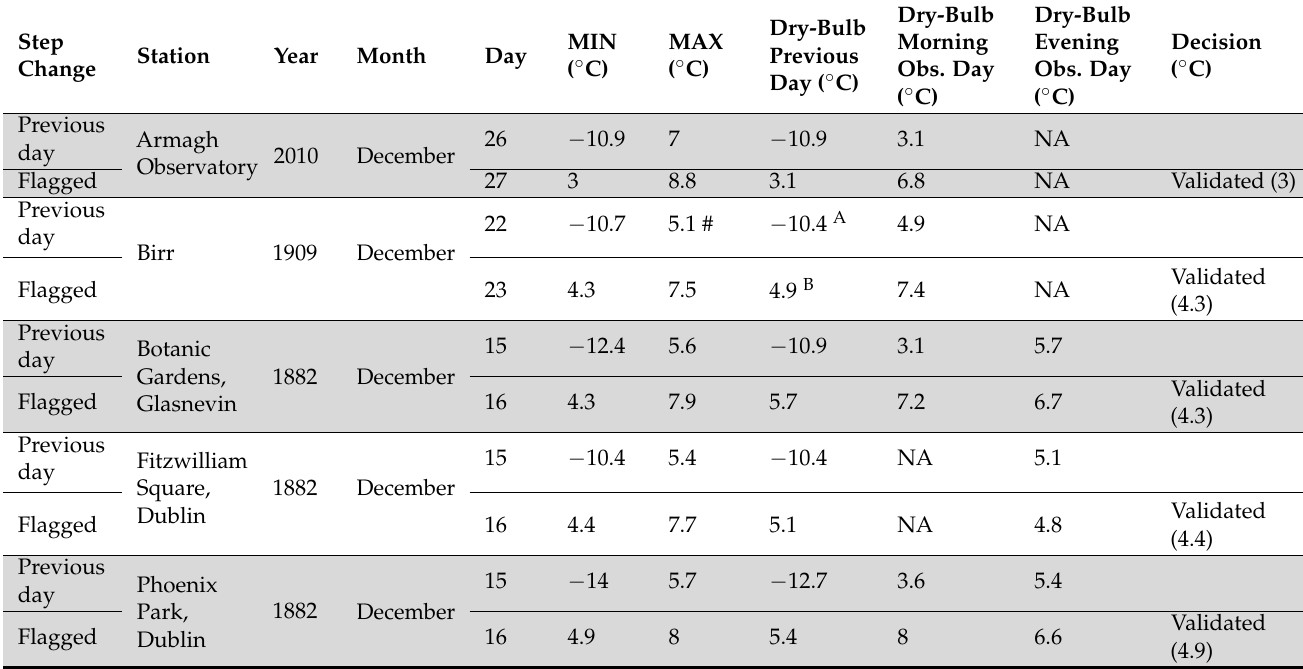
Table A6. Flagged step-change in daily MIN higher than 4.5 standard deviations from the mean (flag 6) and the dry-bulb thermometer registered on previous and observation